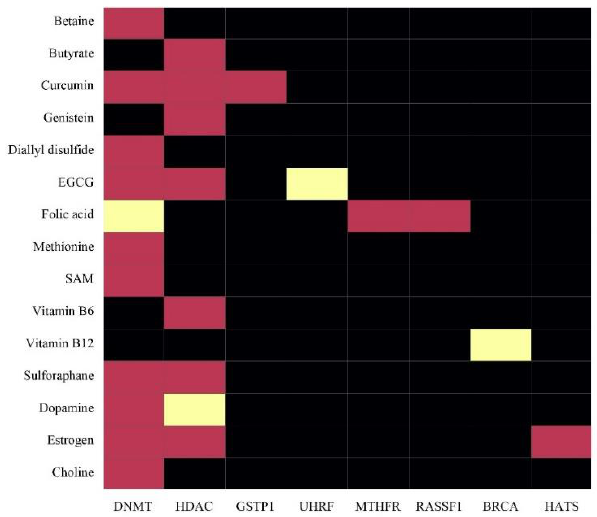
Figure 3. Heat map showing the effect of different nutrients on the expression of epigenetic enzymes. Red, yellow, and black colours indicate downregulation, upregulation, and no studies to date for genes expression, respectively. DNMT: DNA methyl transferase; HDAC: histone deacetylases; UHRF1: ubiquitin-protein transferase 1; MTHFR: methylenetetrahydrofolate reductase; RASSF1A: Ras association domain family protein1 isoform A; BRCA1: breast Cancer gene 1; HMTs: histone methyl transferases; HATs: histone acetyl